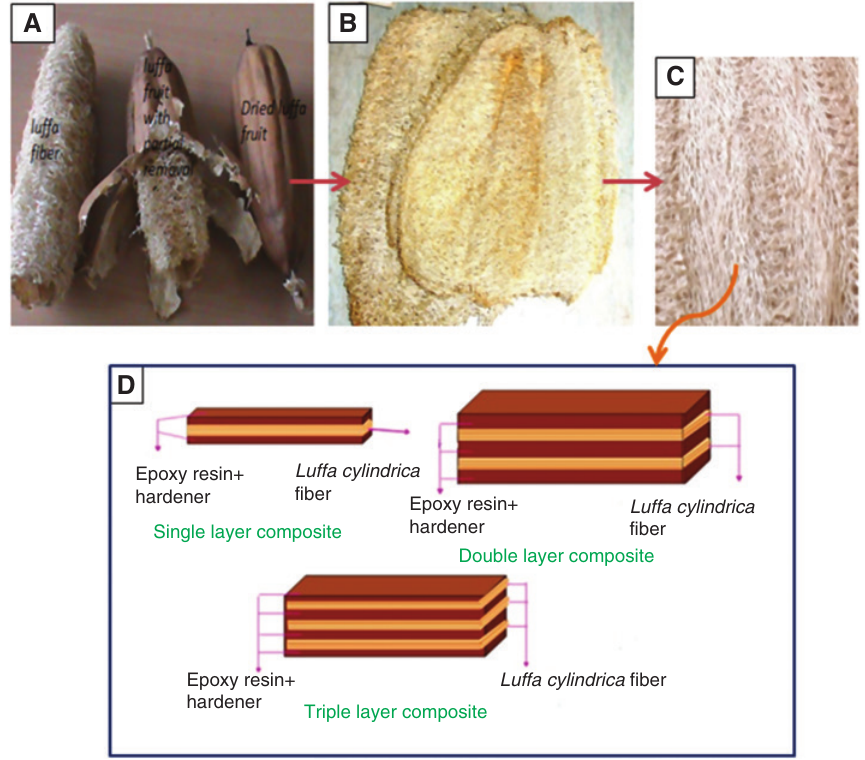
Figure 2: (A) Dry Luffa cylindrica fiber. (B) L. cylindrica fiber opens as natural mat. (C) Rectangular portion of luffa fiber for the preparation of the layered composite. (D) Layered